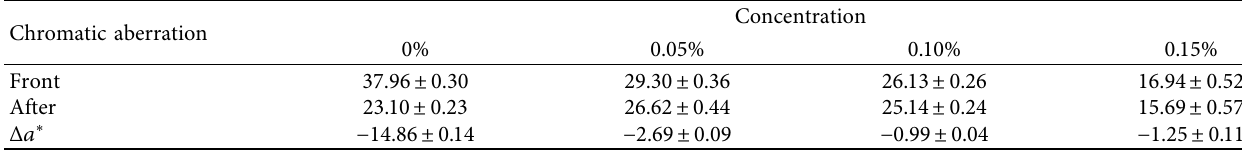
Table 2: a ∗ value and difference before and after the aging of silicone rubber specimens coated with nano-TiO of silicon and aluminum ( F � 20779.00, P < 0 . 05).